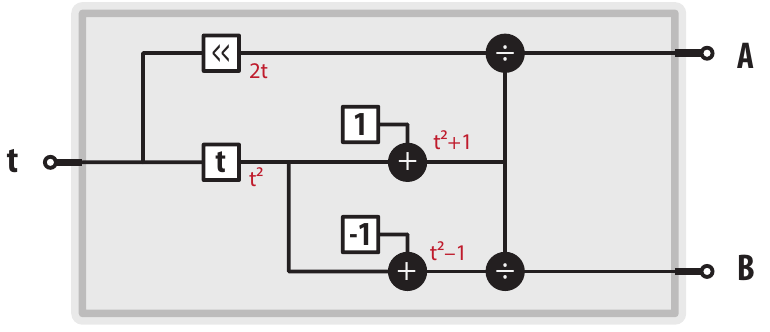
Figure 10. FACTOR module for computing coefficients.